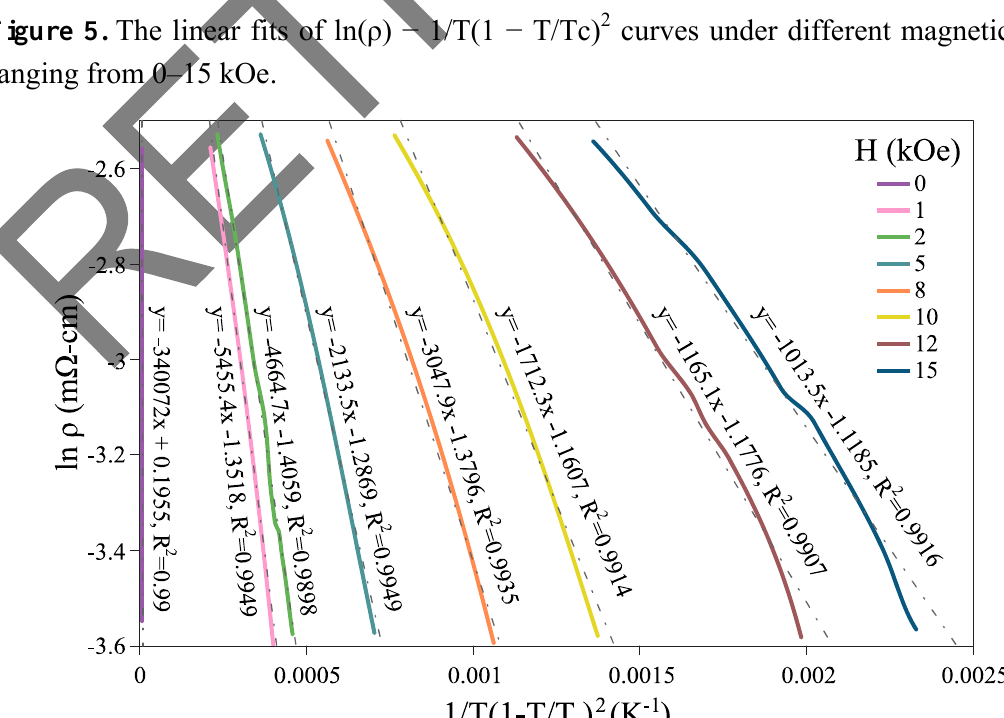
Figure 5. The linear fits of ln( ρ ) − 1/T(1 − T/Tc) 2 curves under different magnetic fields ranging from 0–15